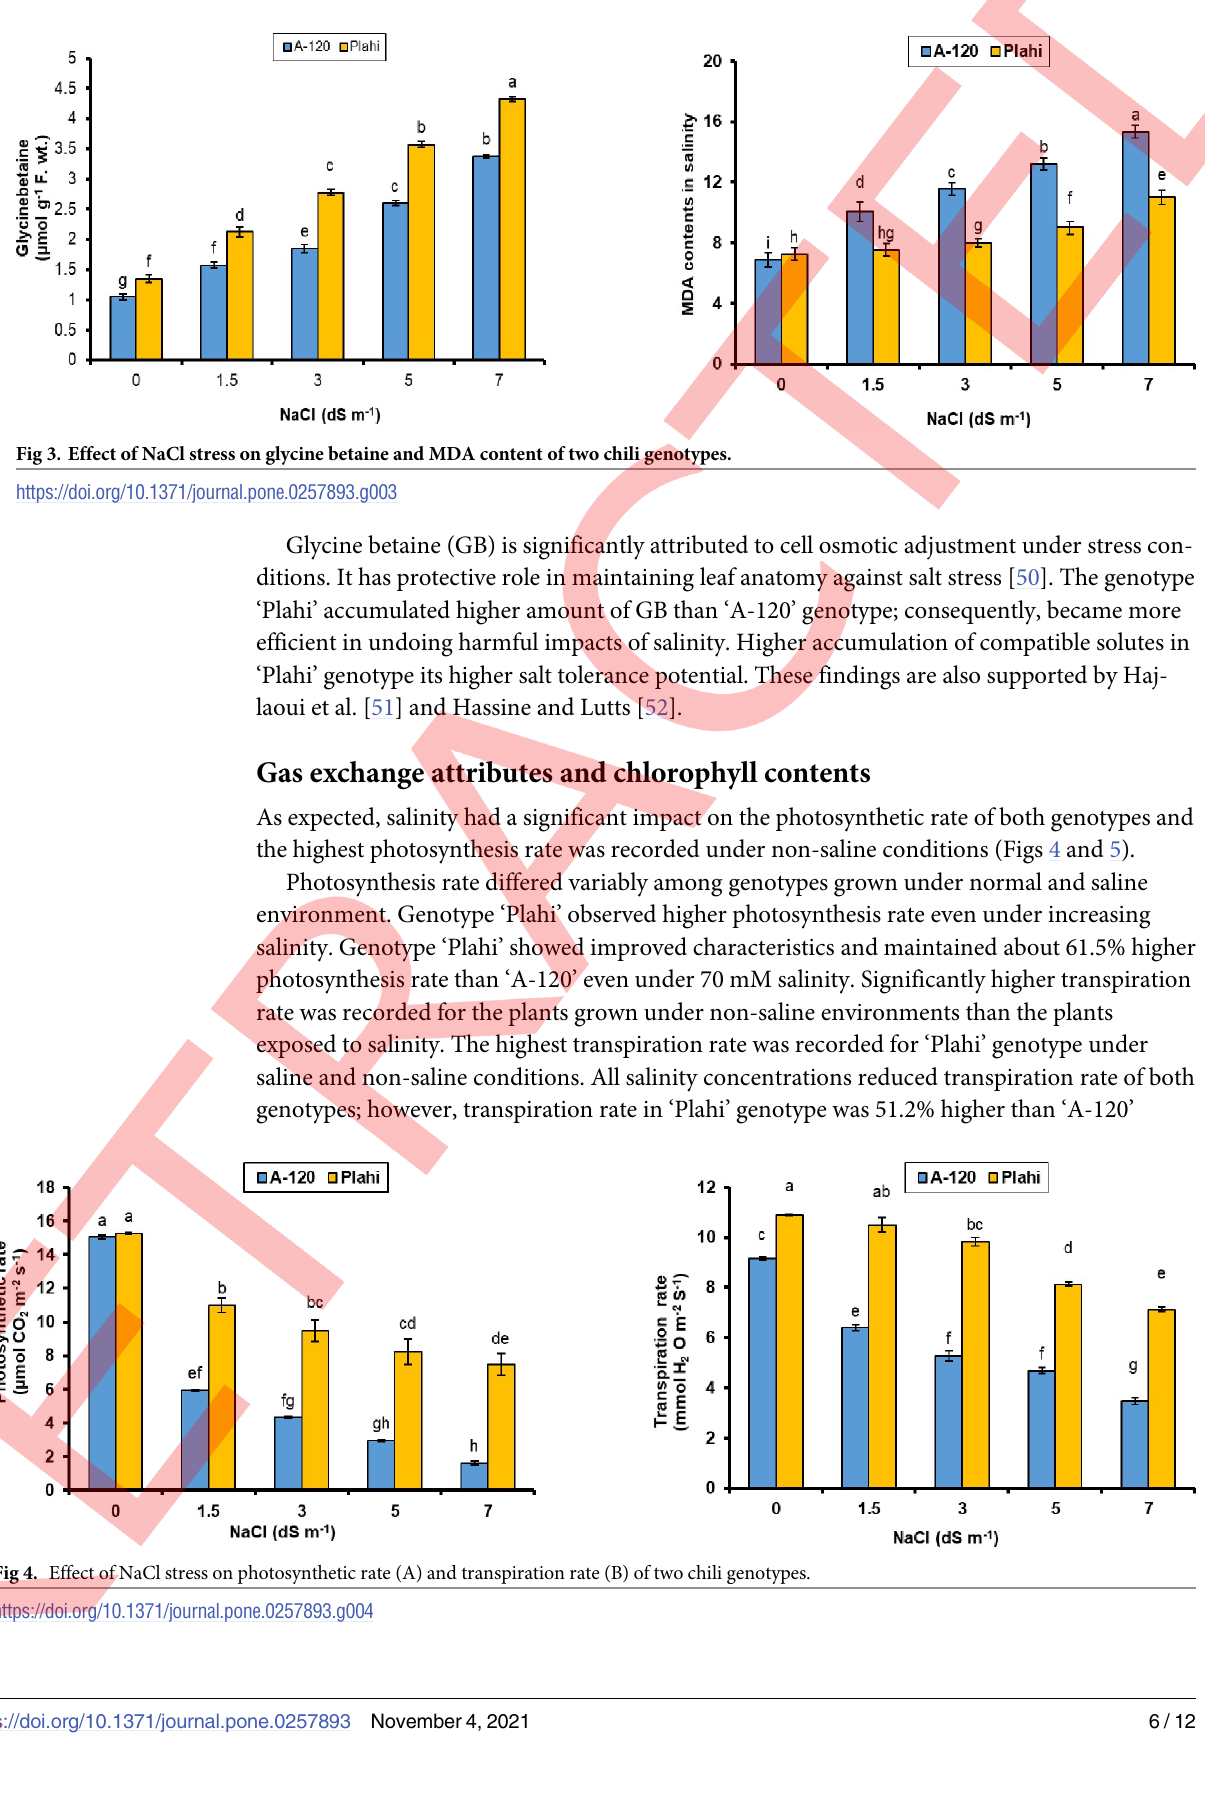
PLOS ONE | https://doi.org/10.1371/journal.pone.0257893 November4,